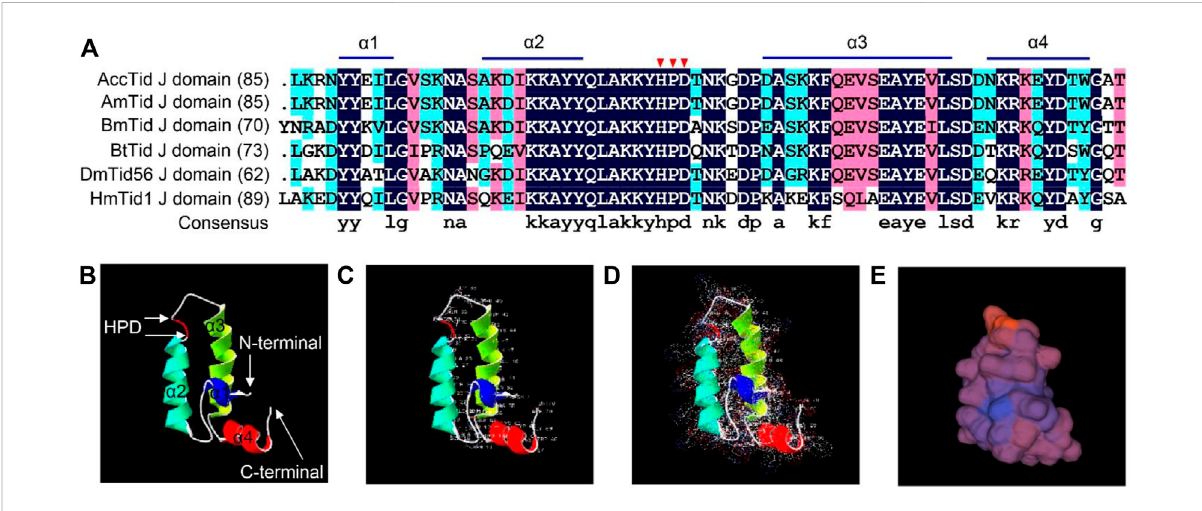
FIGURE 3 MultipleaminoacidalignmentandtertiarystructureoftheTidJdomain. (A) MultipleaminoacidalignmentoftheTidJdomainsof A.cerana and other animals. The HPD motif is indicated by red triangles. AmTid: Apis mellifera Tid. BmTid: Bombyx mori Tid. BtTid: Bemisia tabaci Tid. DmTid: Drosophila melanogaster Tid. HmTid: Homo sapiens Tid. The protein IDs of AmTid, BmTid, BtTid, DmTid and HmTid are XP_026294788.1,